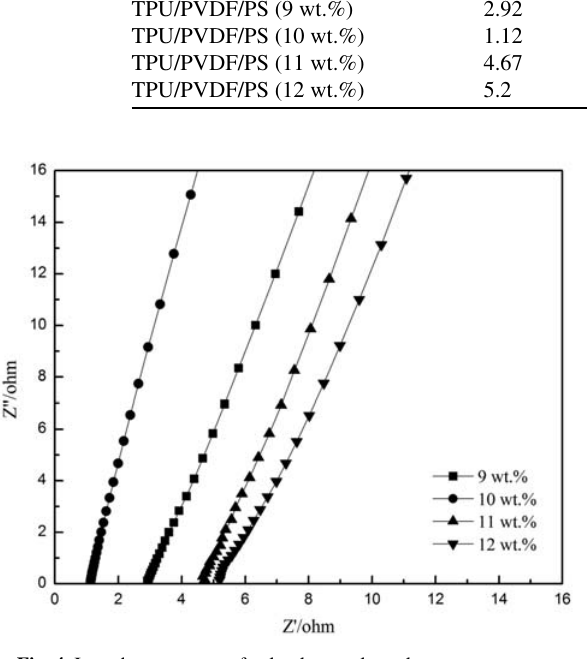
Fig. 4. Impedance spectra of gel polymer electrolytes